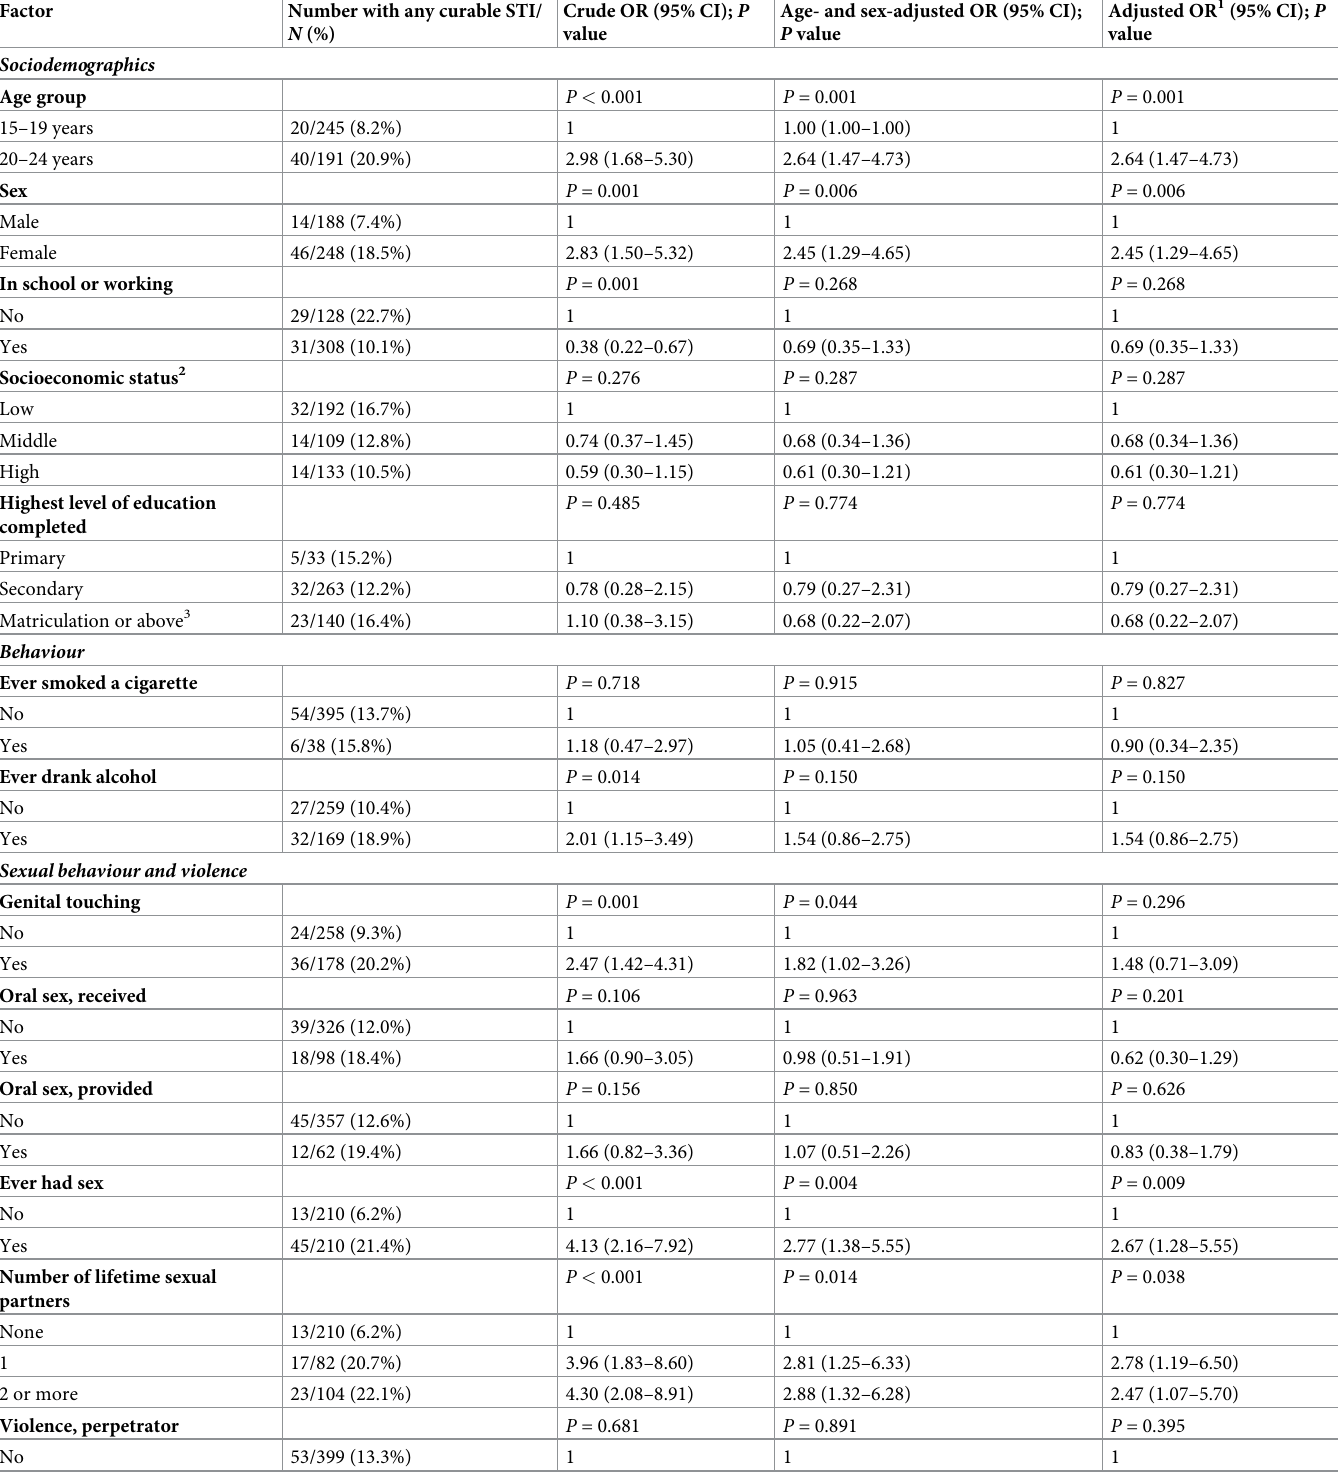
Table 3. Factors associated with chlamydia, gonorrhoea, syphilis and trichomoniasis in a population-based STI survey among young people aged 15–24 years in rural KwaZulu-Natal ( N =